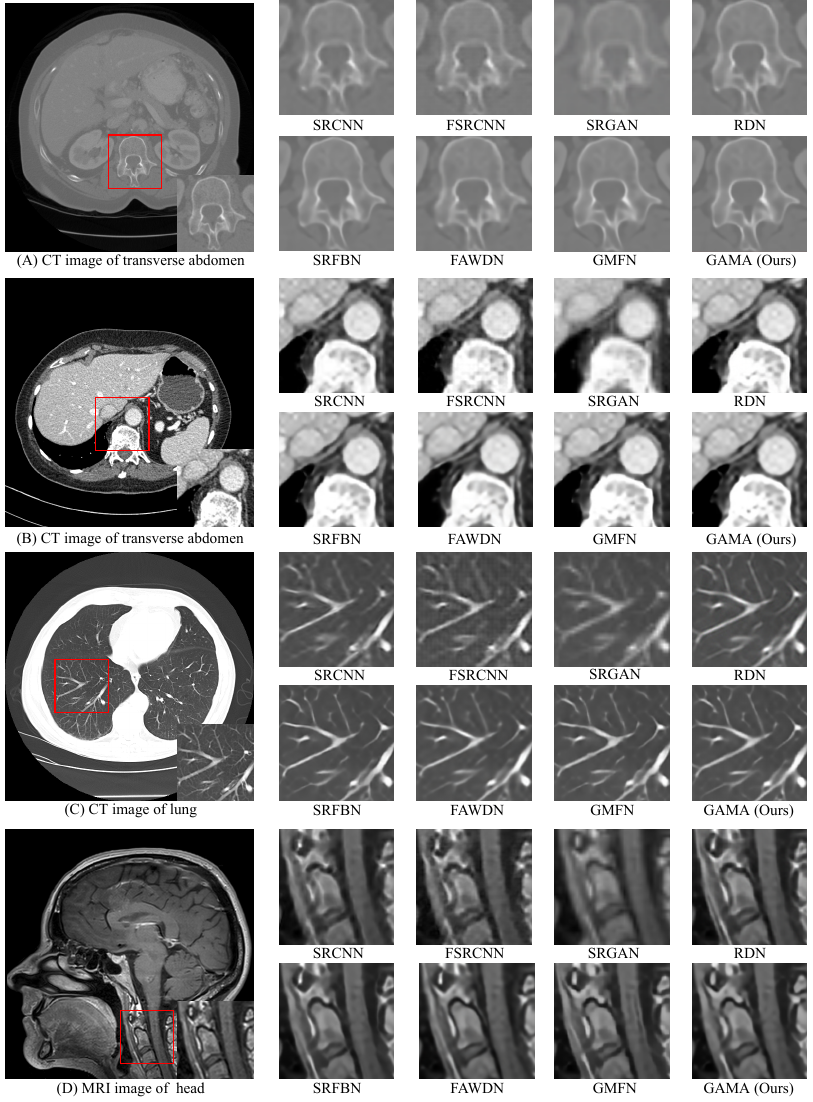
Figure 5. Qualitative comparison of the proposed model with other state-of-the-art methods at ×4 super-resolution based on CT and MRI